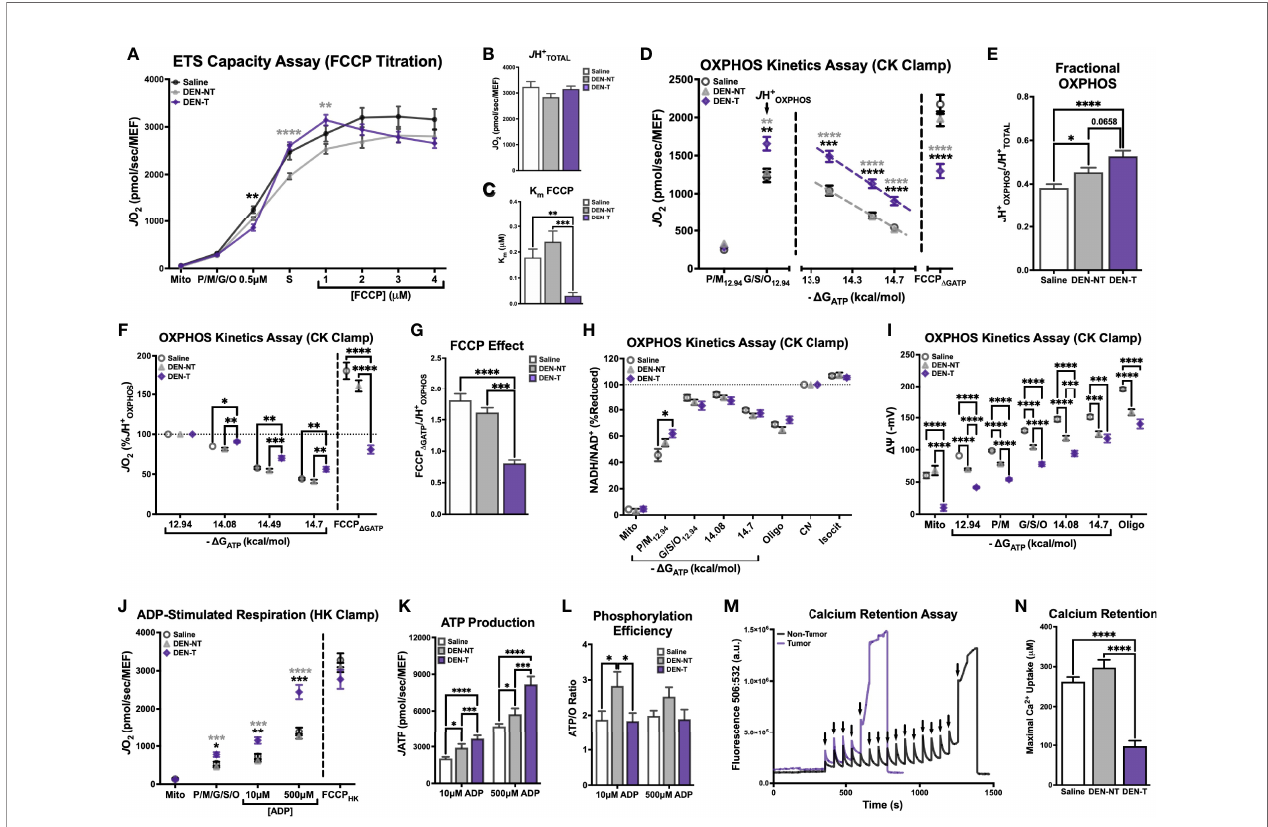
FIGURE 3 | Broad characterization of DEN-induced tumor mitochondria across diverse biochemical stimuli. All experiments were performed using isolated mitochondria and normalized to mitochondrial enrichment factor (MEF). (A) ETS capacity protocol measured in Saline, DEN-NT, and DEN-T, with signi fi cant differences from DEN-T denoted by black asterisks for Saline, gray for DEN-NT. (B) Comparison of J H + TOTAL from (A) . (C) Comparison of K m of FCCP from (A) . (D) OXPHOS capacity protocol measured in Saline, DEN-NT, and DEN-T, signi fi cant differences from DEN-T denoted by black asterisks for Saline, gray for DEN-NT. (E) Comparison of fractional OXPHOS from (D) . (F) OXPHOS capacity protocol from (D) , graphed as % J H + OXPHOS . (G) Comparison of FCCP effect, quanti fi ed as the ratio of FCCP D GATP to J H OXPHOS . (H) Relationship between D G ATP and NAD + /NADH redox poise as % cyanide-induced reduction (CN). (I) Mitochondrial membrane potential across a D G ATP span. (J) ADP-stimulated protocol measured in Saline, DEN-NT, and DEN-T fueled by P/M/G/S/O, signi fi cant differences from DEN-T denoted by black asterisks for Saline, gray for DEN-NT. (K) Comparison of J ATP when stimulated with 10 m M and 500 m M ADP. (L) ATP/ O ratio when stimulated with 10 m M and 500 m M ADP. (M) Representative fl uorometric trace of calcium retention assay (Ex/Em: 506/532); black arrows represent 30 m M additions of calcium; sharp increase in fl uorescence was considered MPTP opening. (N) Comparison of maximal calcium uptake ( m M) prior to MPTP opening. Data are presented as mean ± SEM and analyzed by two-way ANOVA (A, D, F, H – L) and one-way ANOVA (B, C, E, G, N) . *p < 0.05, **p < 0.01, ***p < 0.001, ****p <